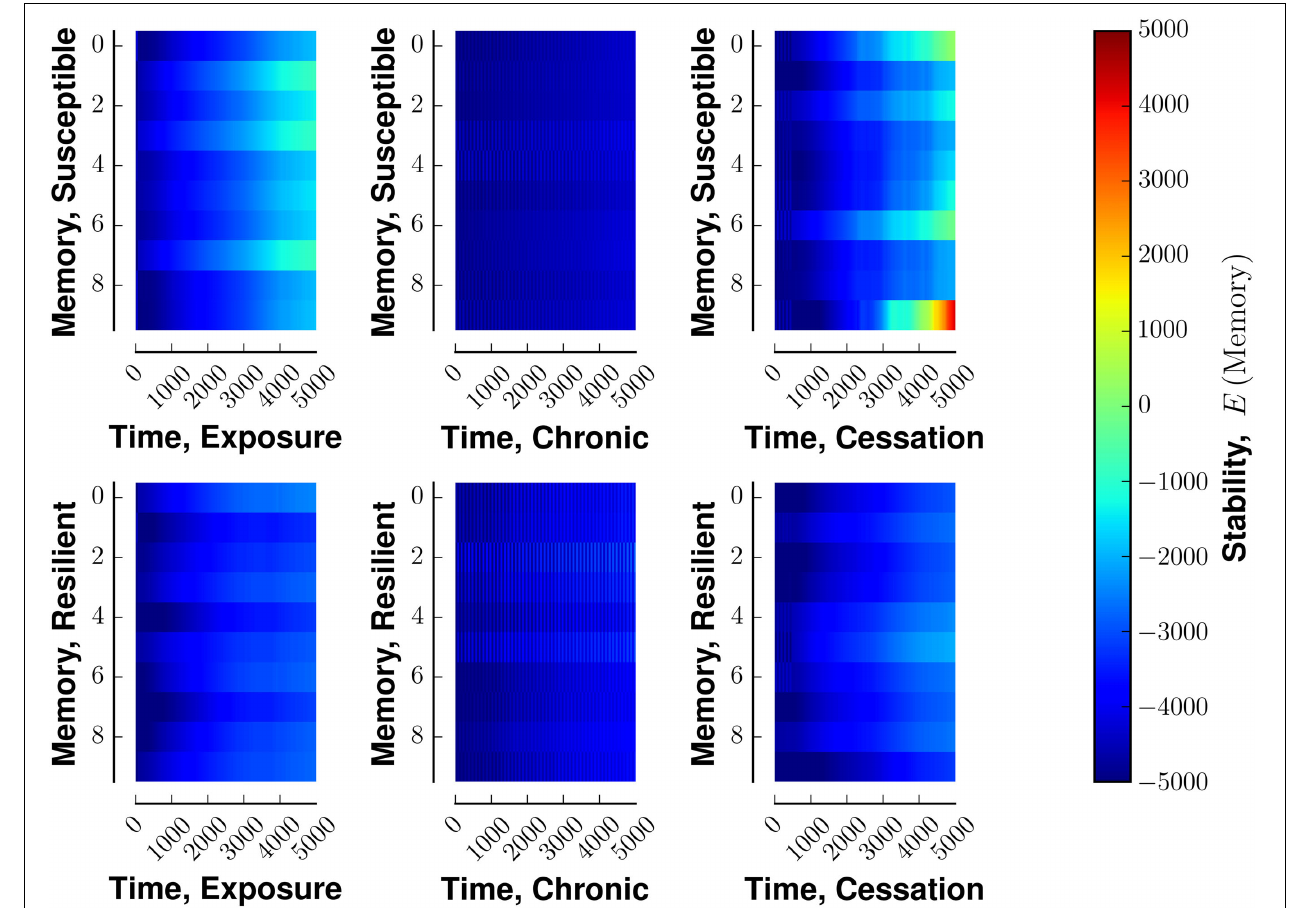
FIGURE 6 | Stability of fixed points of network in the face of various stimulus-reward schemata. Layout similar to Figure 3 . The top row denotes a susceptible reward profile, the bottom a resilient profile. The left column